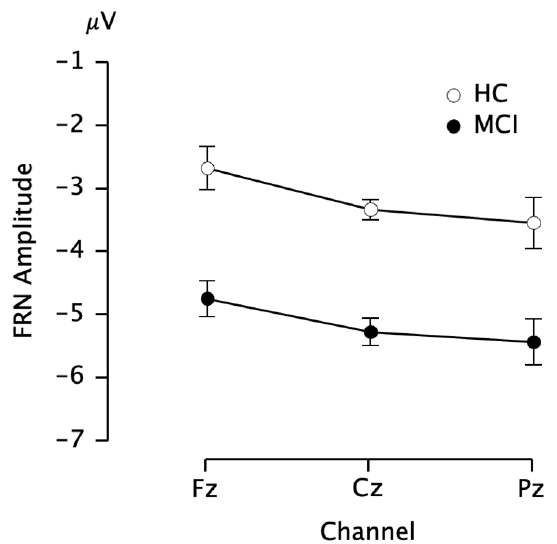
Figure 3. Comparisons of FRN amplitude between mild cognitive impairment (MCI) and healthy control (HC) groups. Values are mean ± S.E. FRN: feedback-related negativity.